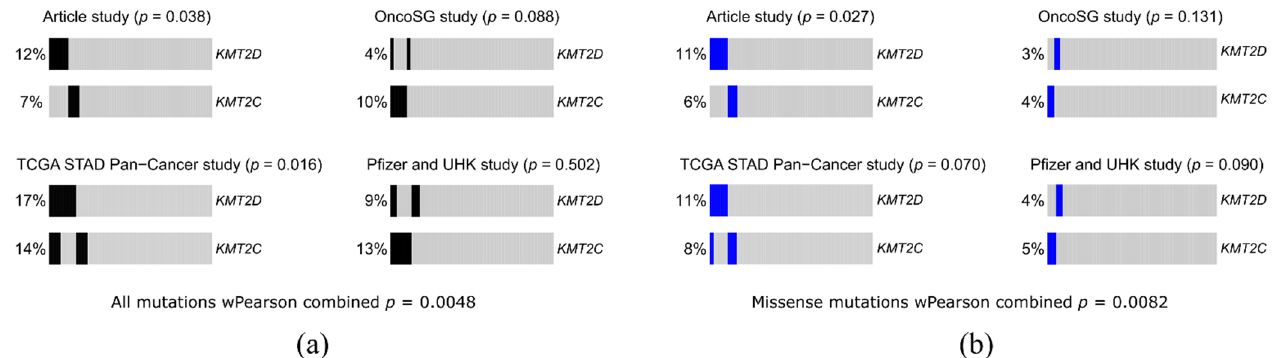
Figure 6. Analysis of mutual exclusivity of KMT2D and KMT2C mutations on the data presented in this article and in other gastric cancer mutation databases. Portions of samples without mutations in KMT2D or KMT2C are shown in grey; ( a ) analysis of all types of mutations, excluding amplification and deep deletions, portions of samples with mutations in KMT2D or KMT2C are colored black; ( b ) analysis of missense mutations only, portions of samples with missense mutations in KMT2D or KMT2C are colored blue.